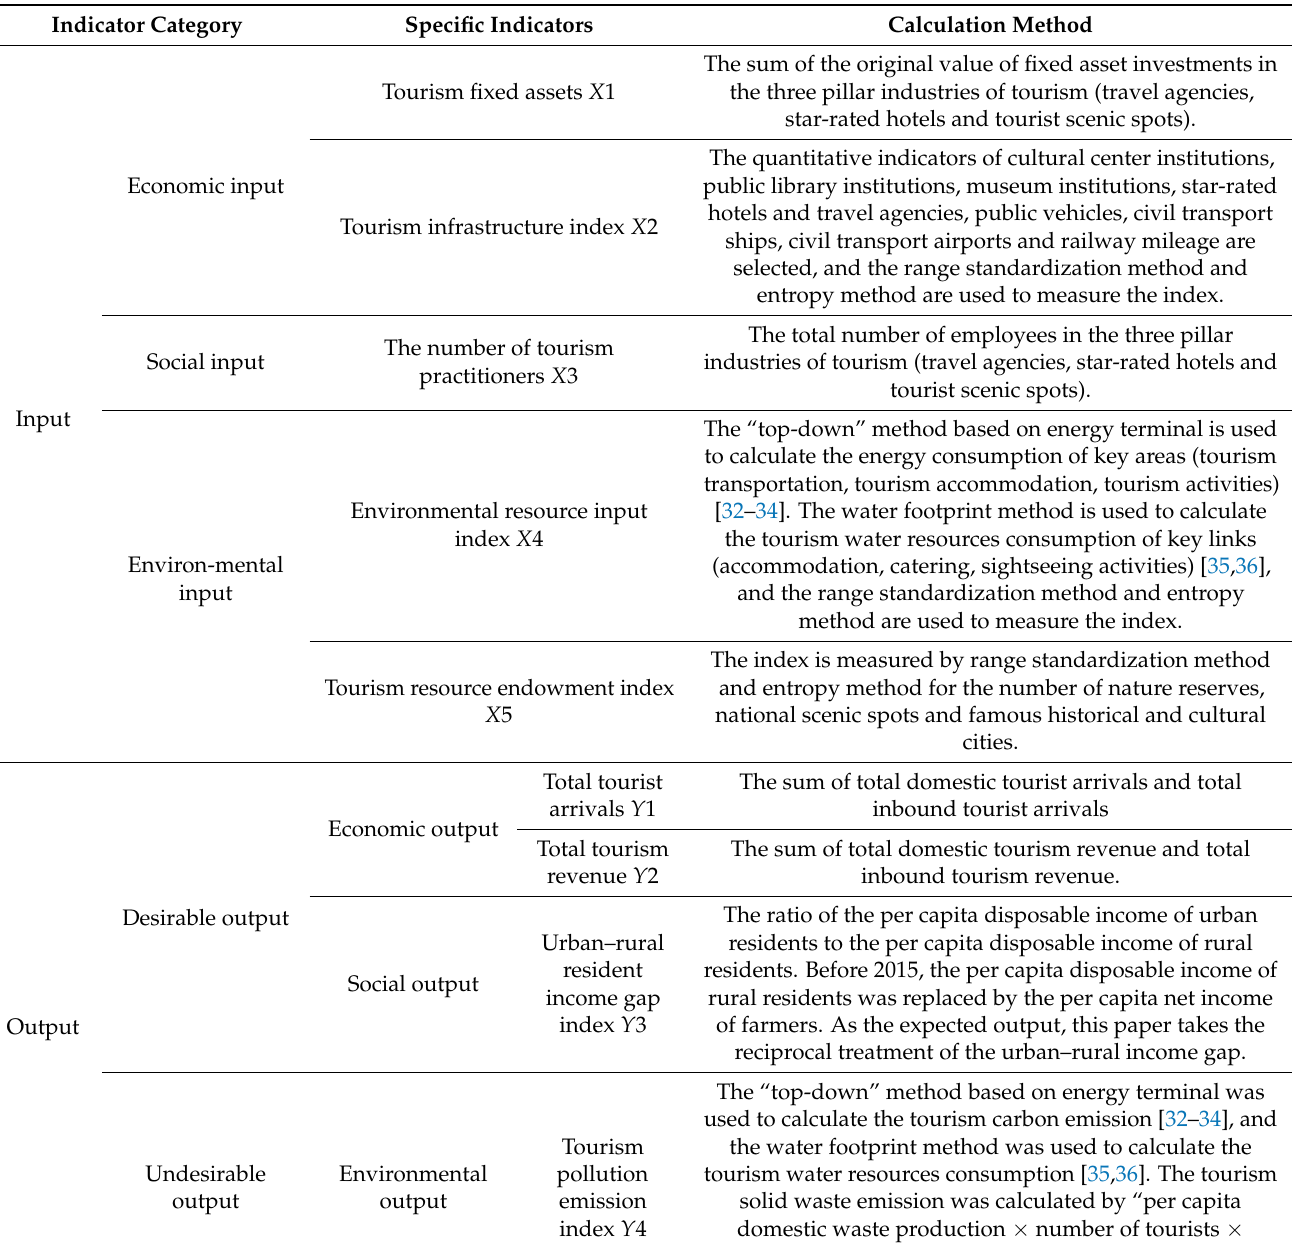
Table 1. Tourism efficiency